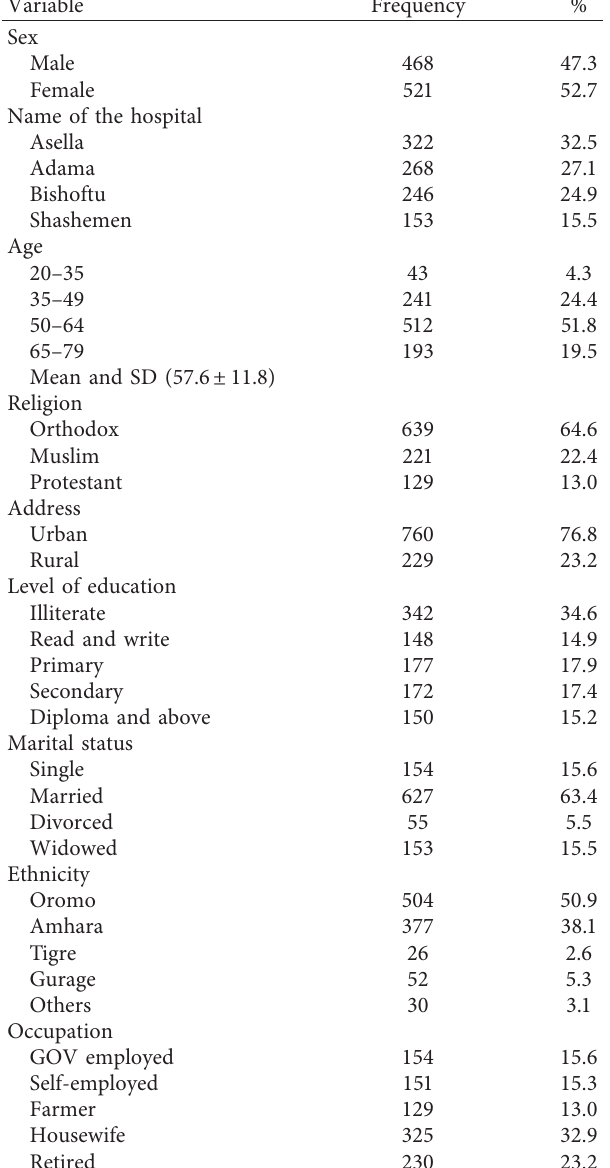
Table 1: Sociodemographic characteristics of hypertensive patients in Central Ethiopia, 2017 ( n � 989).